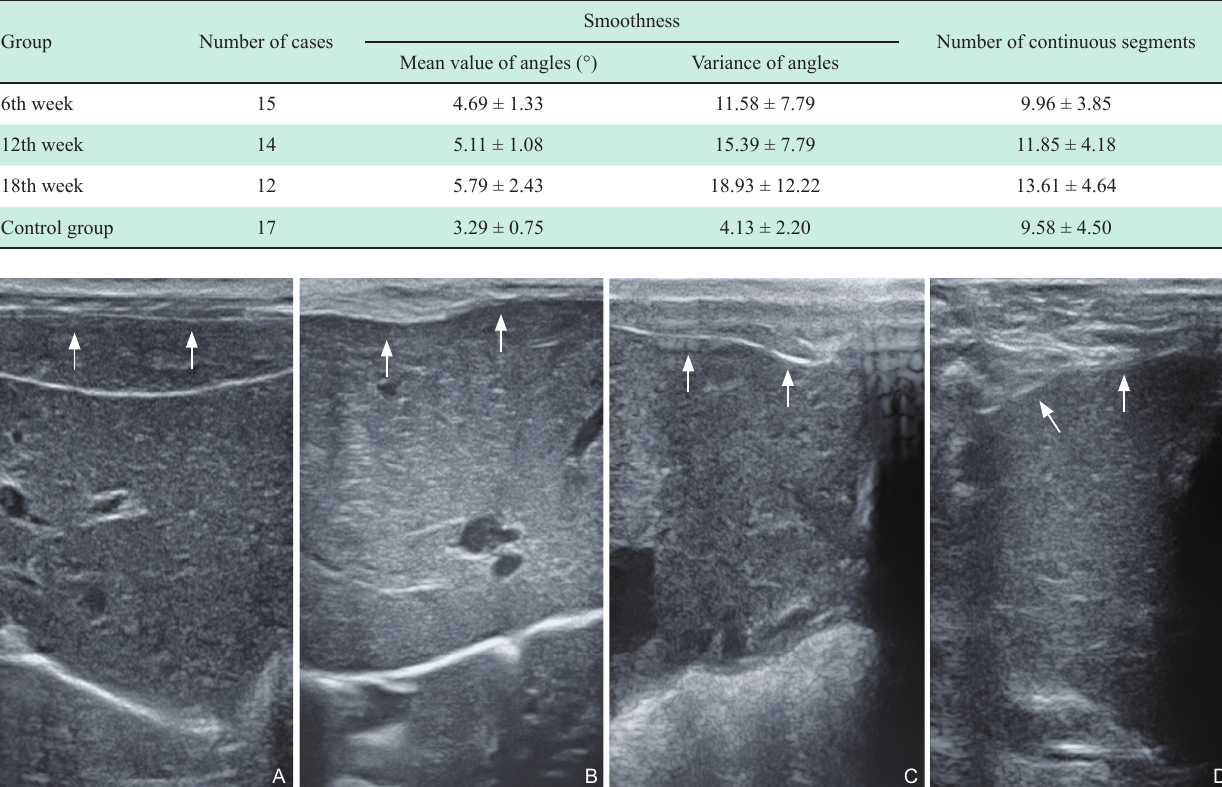
Figure 2 High-frequency ultrasound images of hepatic capsule of rabbits with different degrees of cirrhosis. (A) Control group; (B) 6-week group; (C) 12-week group; (D) 18-week group, arrows refer to hepatic capsule.